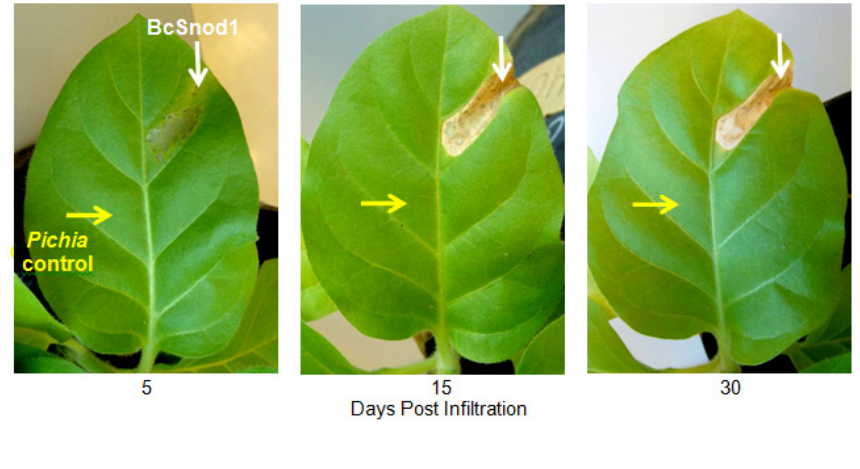
Figure 5. Tobacco leaves infiltrated with HPLC purified P. pastoris produced BcSnod1 and the same volume of vector only control. In tobacco, hypersensitive response was observed from day 5 onwards, turning into necrosis after 15 dpi for BcSnod1. Necrosis did not spread to adjoining areas. No discoloration was observed for the